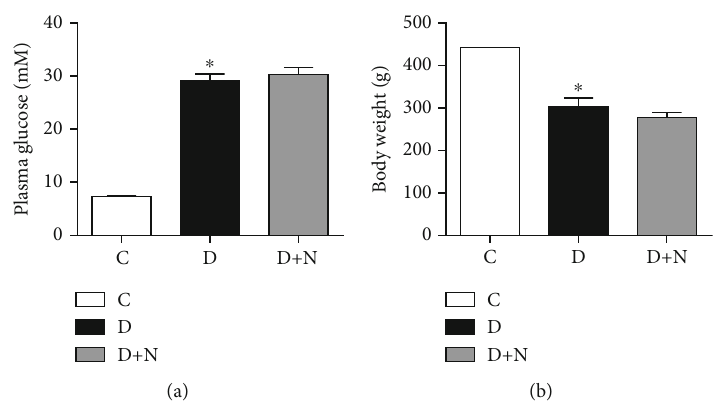
Figure 2: The e ff ect of three weeks of N-acetylcysteine treatment on blood glucose and body weight in rats with STZ-induced diabetes at 4 weeks of diabetes. The data are expressed as means ± SD ( n = 6 ). C: control; D: diabetes; NAC: N-acetylcysteine; a P < 0 : 05 vs.